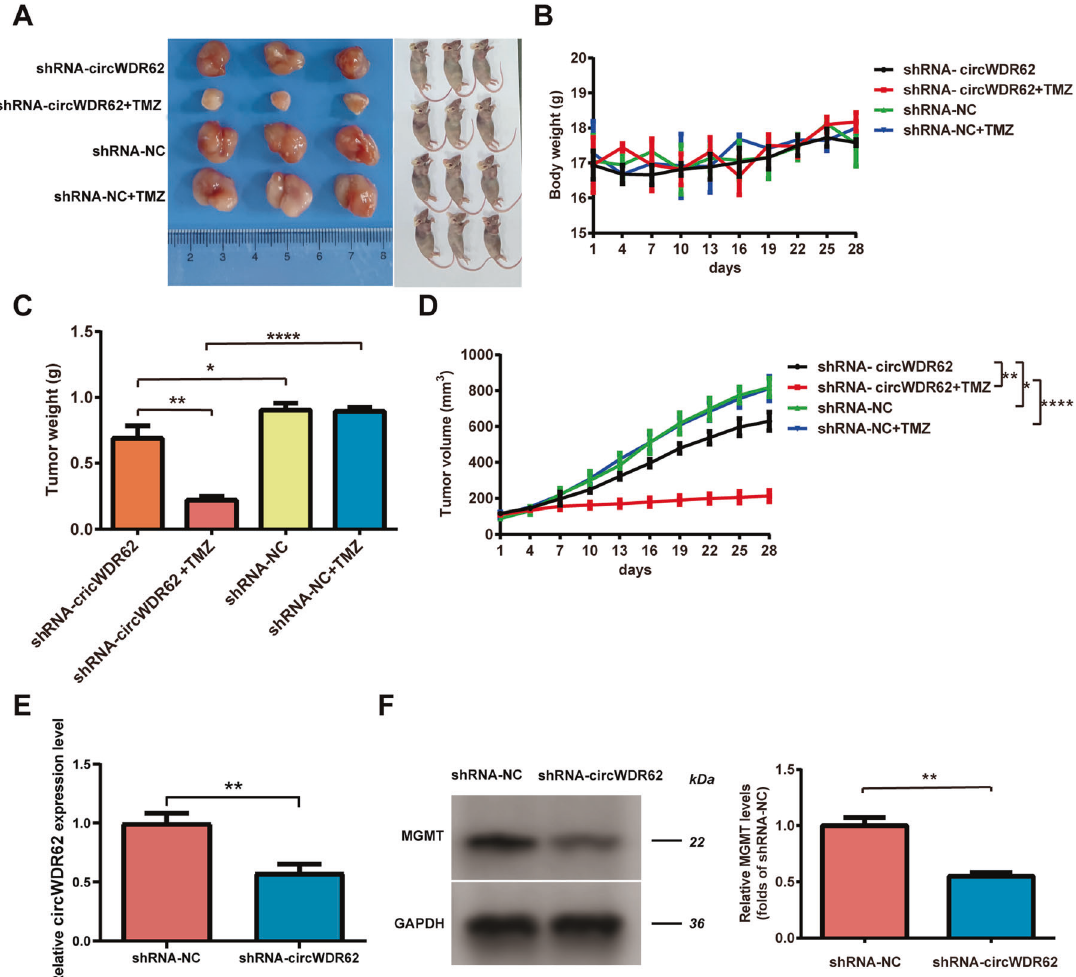
Fig. 6 circWDR62 enhances glioma TMZ resistance and tumour growth in vivo. A Tumours from mice in different groups are shown. Tumour-bearing nude mice from different groups are shown. B Body weight changes in tumour-bearing mice. C , D The tumour weight ( C ) and tumour volume ( D ) of the mice were measured. E The expression of circWDR62 was measured in the tumour tissue from each group by qRT – PCR. F The MGMT protein expression level in tumour tissues was measured by WB PCNA, and N-cadherin protein expression and upregulation of E-cadherin protein expression in U343-R and U251-R cells (Additional fi le: Fig. S3A – E).